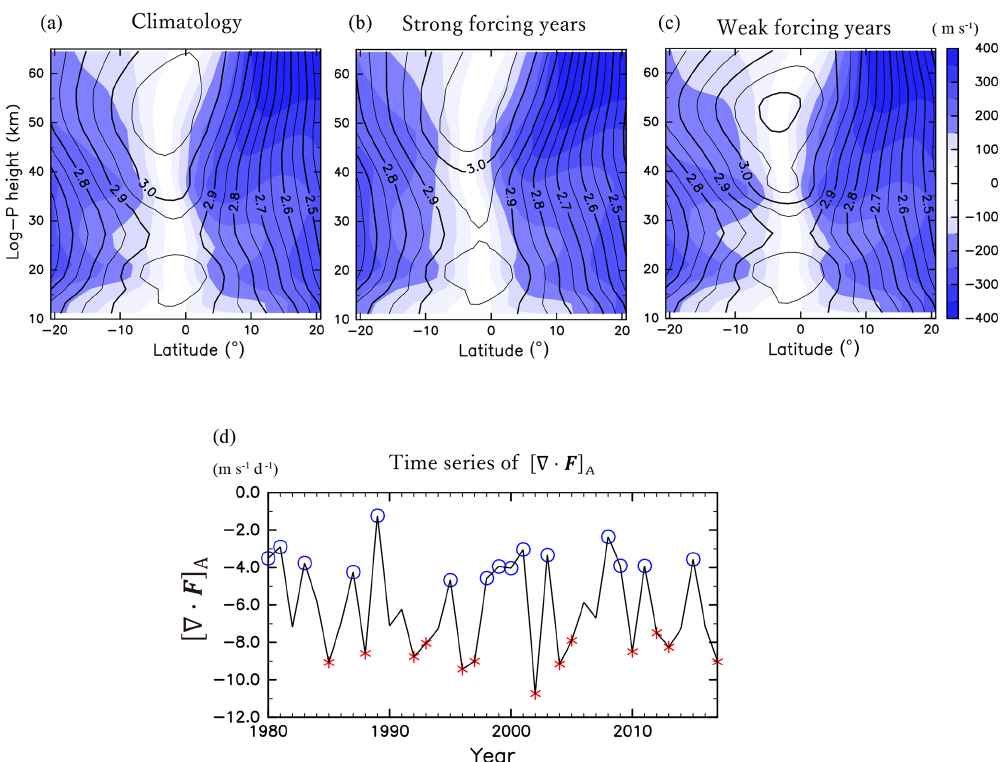
Figure 5. Meridional cross sections of the (a) climatology of absolute angular momentum M (contours, 10 9 m 2 s − 1 ) and its meridional gradient M y (colours, ms − 1 ) for 1980–2017, (b) composite for the strong wave forcing, and (c) composite for the weak wave forcing. Contour intervals are 5 × 10 7 m 2 s − 1 . (d) Time series of [∇· F ] A . The red and blue marks indicate the years used for (b) and (c) ,